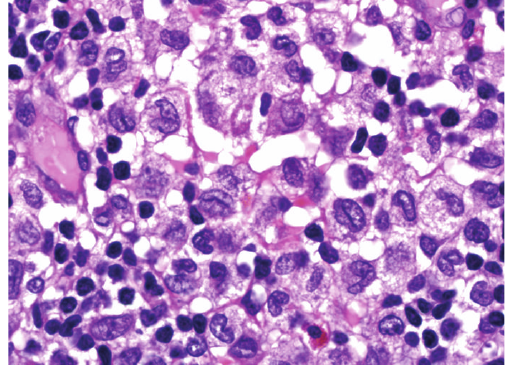
Figure 2: HE of the focus of histiocytes. Focus histiocytic infiltrate with co ff ee bean morphology, lymphoid infiltrate with eosinophils. (H.E. 200x)